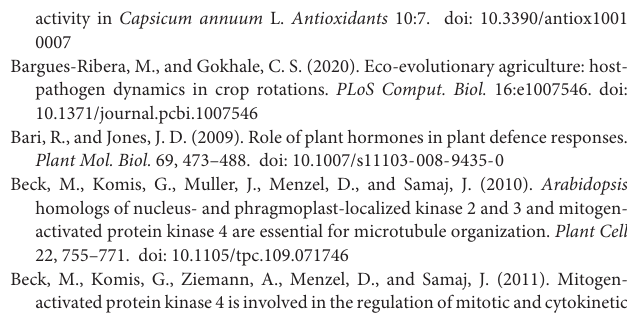
Supplementary Table 1 | Oligonucleotides for the plasmid constructs and PCR used in this